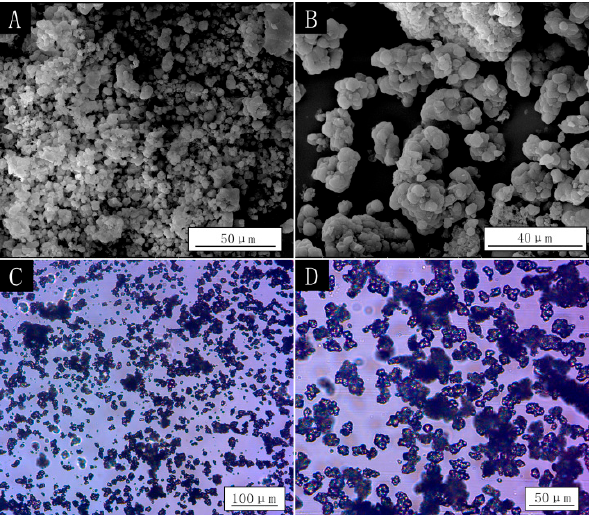
Figure 3. Microstructure of 0.67:1 microcapsules: ( A , B ) SEM of microcapsules, ( C , D ) OM of mi-